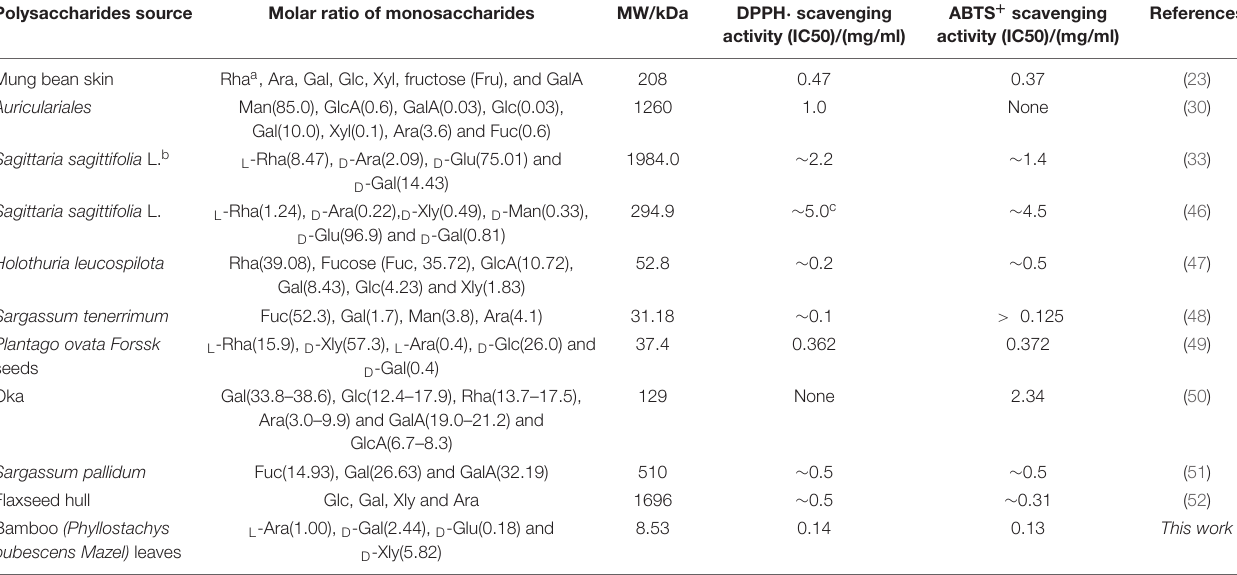
TABLE 2 | A mini summary for DPPH · and ABTS + radical scavenging with molecular weight (MW) of some recent reported polysaccharides. Polysaccharides